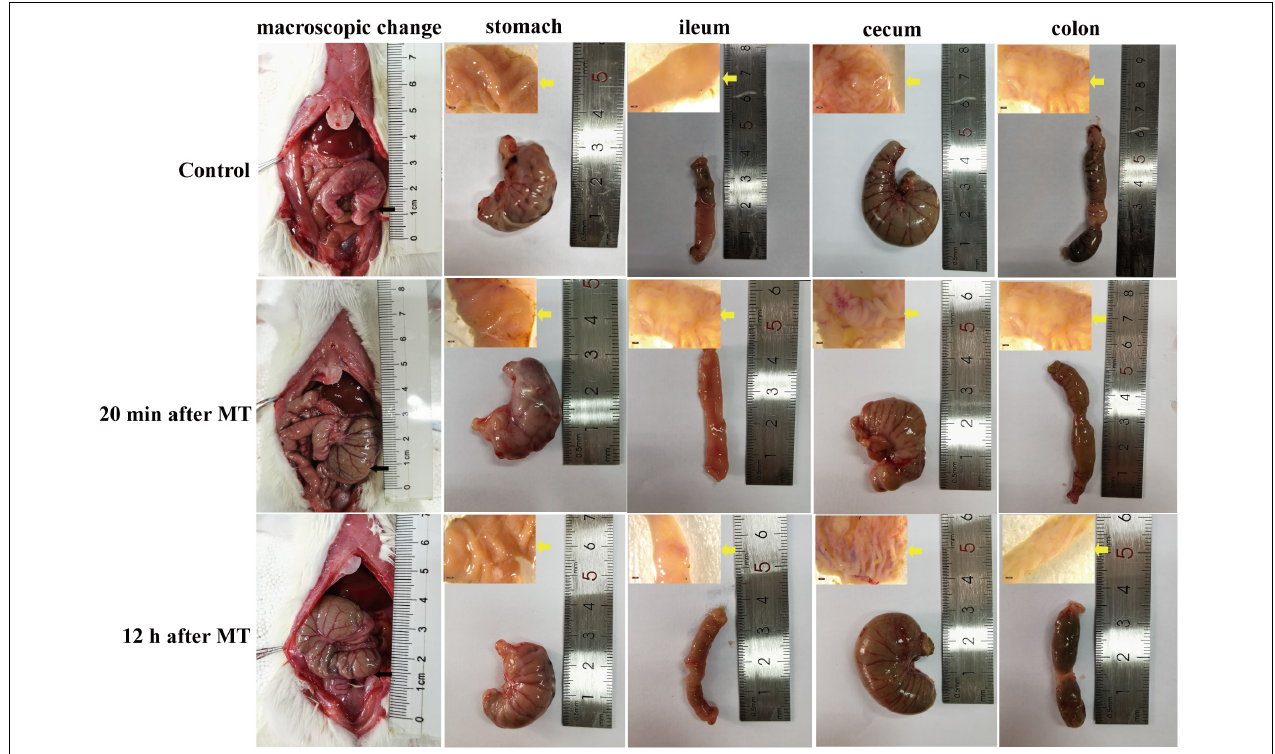
FIGURE 9 | Macroscopic morphological images of gastrointestinal organs of the SD rats at 20 min and 12 h after MT. The black arrow in the figure was referred to the location of the cecum in vivo . The yellow arrow was referred to the anatomic mucosa of stomach, ileum, cecum and colon.